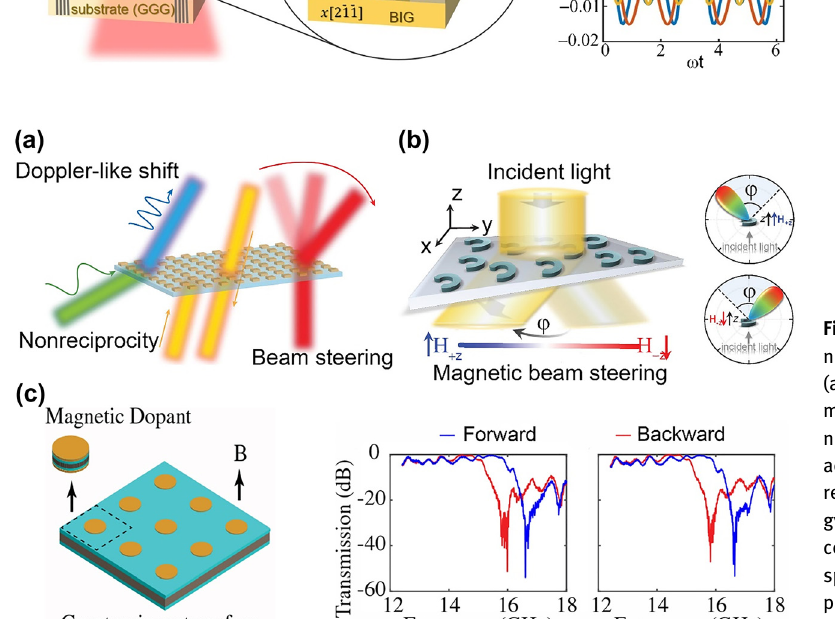
Figure 11: Magnetic field controlled active and nonreciprocal